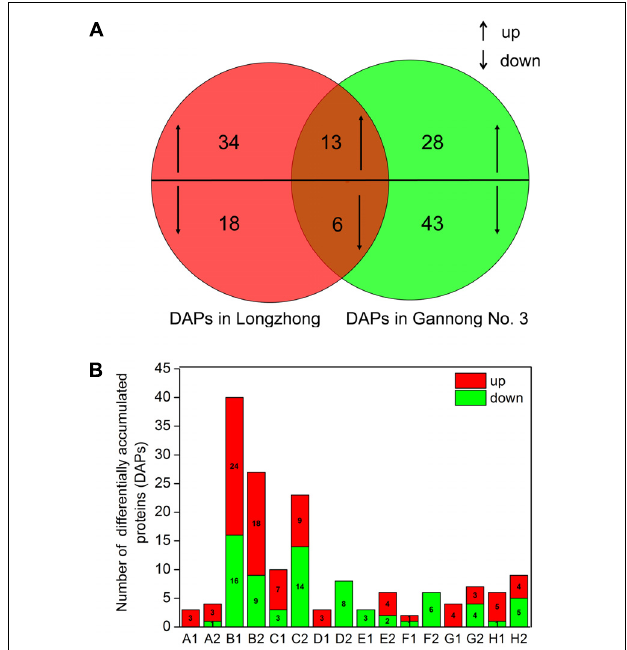
FIGURE 6 | Graphical representation and functional cataloging of DAPs (A) Venn diagram shows the number of common, significantly up-regulated and down-regulated proteins in two alfalfa varieties under PEG-induced osmotic stress (up- and downward arrows represent up-regulated and down-regulated proteins, respectively). (B) The column chart shows the functional categories of the DAPs including carbohydrate and energy metabolism (A1, A2), stress and defense (B1, B2), protein metabolism (C1, C2), membrane and transport (D1, D2), signal introductions (E1, E2), transcription (F1, F2), cell wall and cytoskeleton metabolism (G1, G2), in addition to and unknown functions (H1, H2) (red and green bars represent up- and down-regulated proteins, respectively. A1, B1, C1, D1, E1, F1, G1 and H1 represent correspondingly functional categories of the DAPs in Medicago sativa L. cv. Longzhong; and A2, B2, C2, D2, E2, F2, G2, and H2 represent correspondingly functional categories of the DAPs in Medicago sativa L. cv. Gannong No.